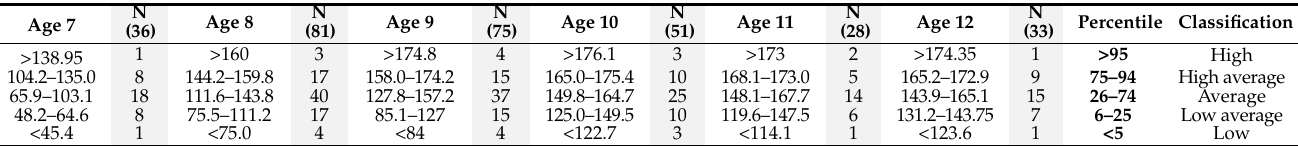
Table 1. Range of raw score results for Zareki-R total, number of students for each per percentile and classification by age